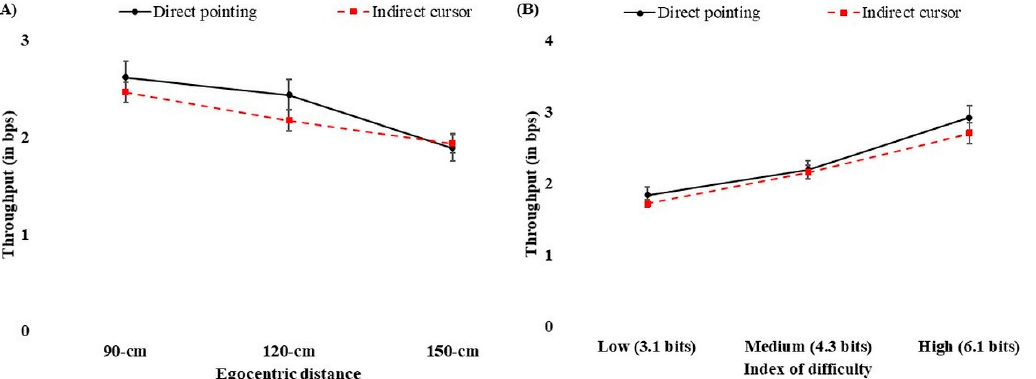
Figure 6. Results of throughput for direct pointing and indirect cursor interaction techniques with respect to egocentric distance ( A ) and index of difficulty ( B ). The error bar represents standard error of mean.